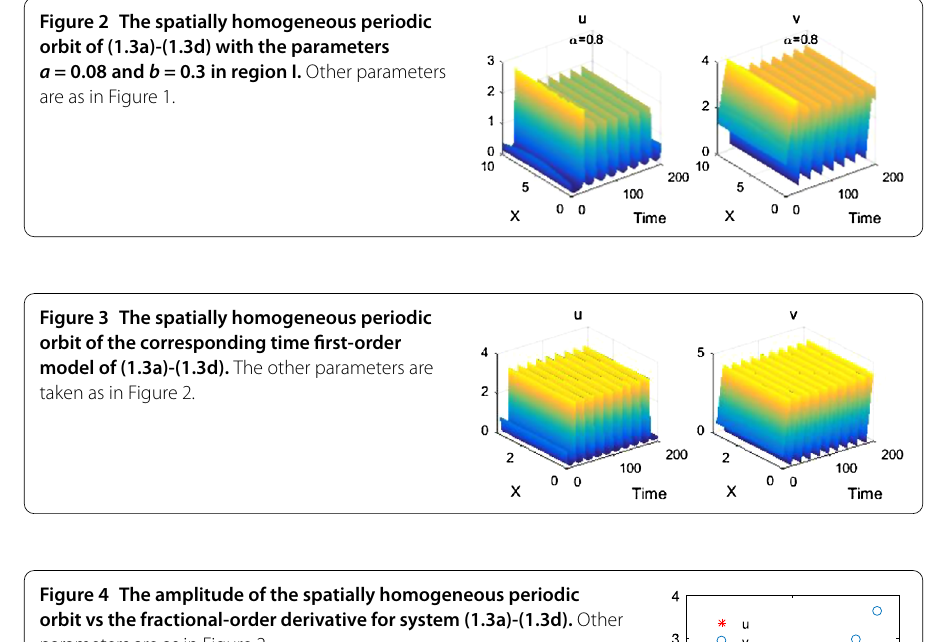
Figure 4 The amplitude of the spatially homogeneous periodic orbit vs the fractional-order derivative for system (1.3a)-(1.3d). Other parameters are as in Figure 2.